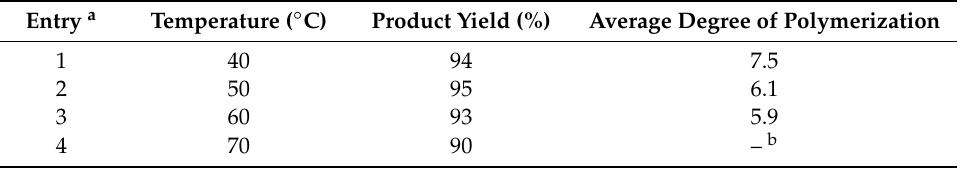
Table 3. Activity of catalysts at di ff erent